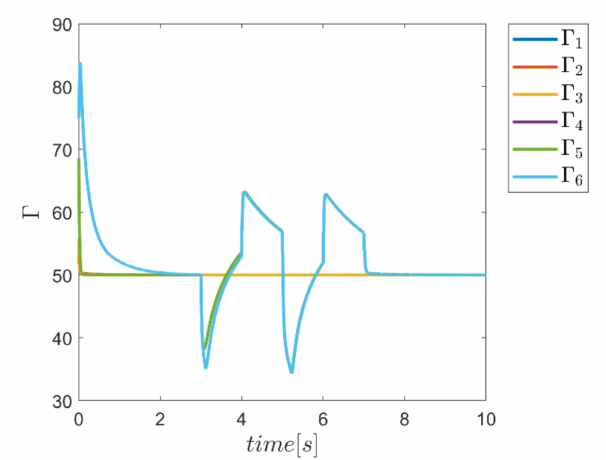
Figure 24. Adaptive variation of the coefficents of Γ for individual Γ fuzzy